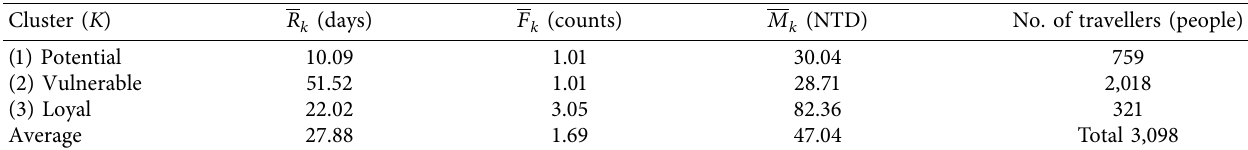
Table 9: Clustering results by K -means for 2018 Q 1.